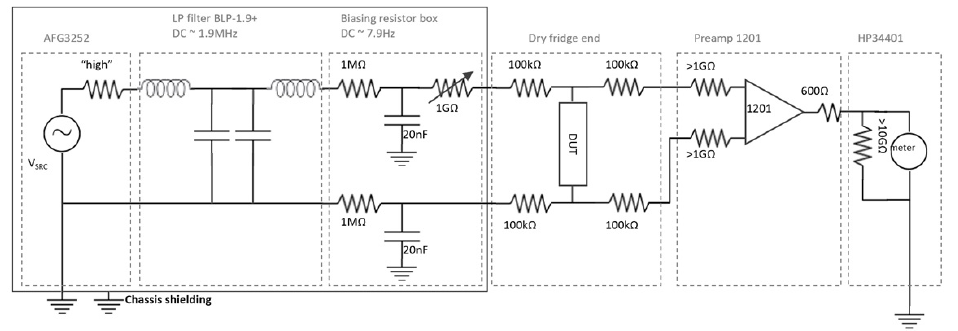
Figure A2. The wiring schematics for DC current source measurements. The device-under-test (DUT) was mounted inside a sample holder thermally anchored to the mixing chamber of the dilution